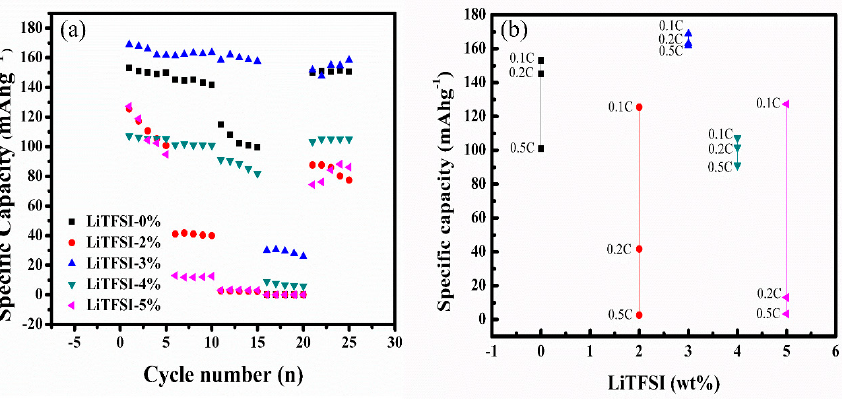
Figure 6. ( a ) Cyclic performance curves of Li|LATP/PVDF-HFP| X% LiTFSI (X = 0, 2, 3, 4, 5) +LiFePO 4 cells at ambient temperature and ( b ) the change in the discharge capacity with a change in the LiTFSI content at di ff erent C